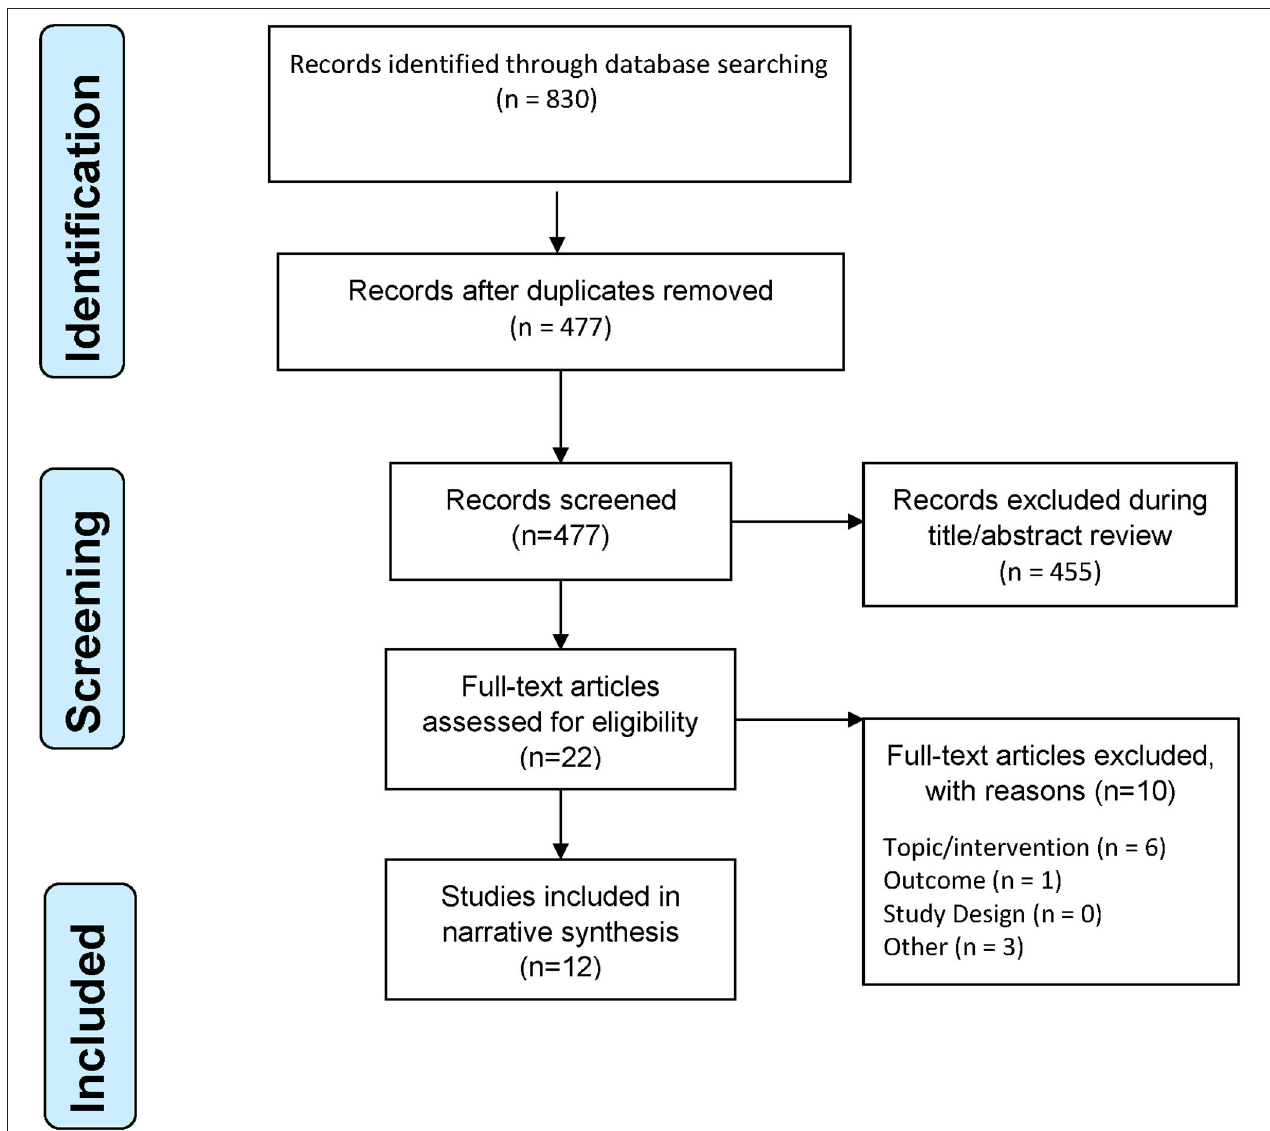
FIGURE 1 | PRISMA flowchart of study selection